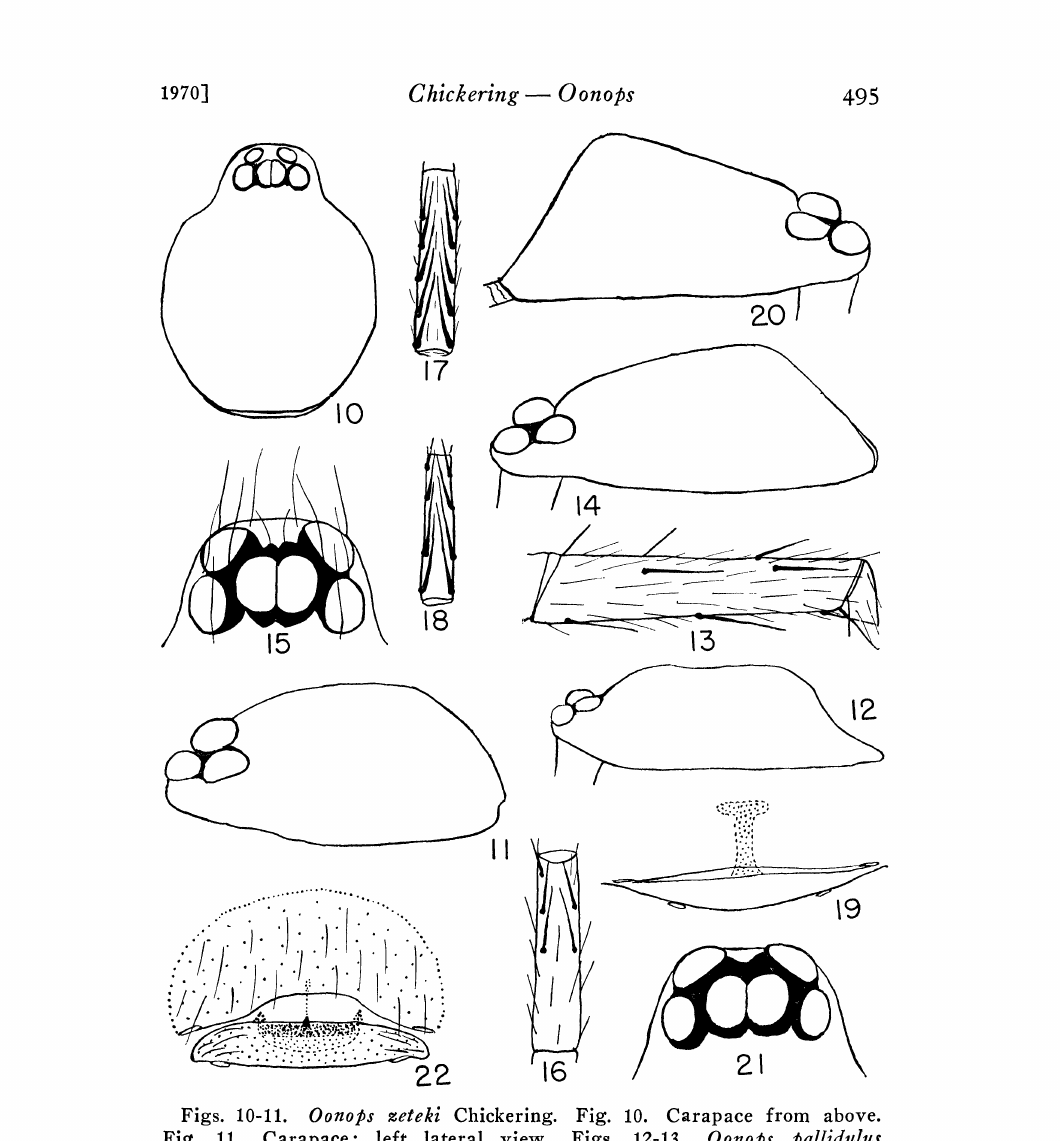
Figs. 10-11. Oonops zetekl Chiekering. Fig. 10. Carapace from above. Fig. 11. Carapace; left lateral view. Figs. 12-13. Oonops pallidulus (Chiekering). Fig. 12. Carapace; left lateral view. Fig. 13. Left fourth tibia; dorso-prolateral view. Figs. 14-19. Oonops persitus sp. nov. Fig. 14. Carapace of holotype; left lateral view. Fig. 15. Eyes of holotype from above. Figs. 16-18. First femur, tibia and metarsus, respectively from below. Fig. 19. Epigynal area o.f holotype from below. Figs. 20-22. Oonops amacus sp. nov. Fig. 20. Carapace of holotype; right lateral view. Fig. 21. Eyes of holotype from above. Fig. 22. Epigynal area from